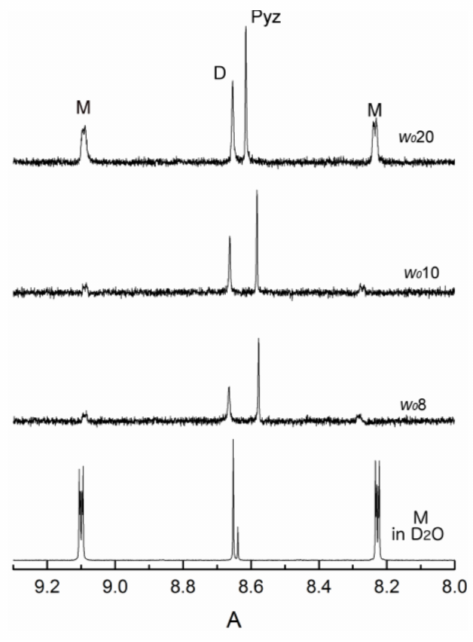
Figure 6. 1 H-NMR spectra recorded at 300 MHz of 0.020 M and in 0.75 M AOT/isooctane at pH 8.82. Starting from the bottom: M in D 2 O, M in RM sizes w 0 8, 10, and 20. Spectra were taken approximately 30 min after preparation of the